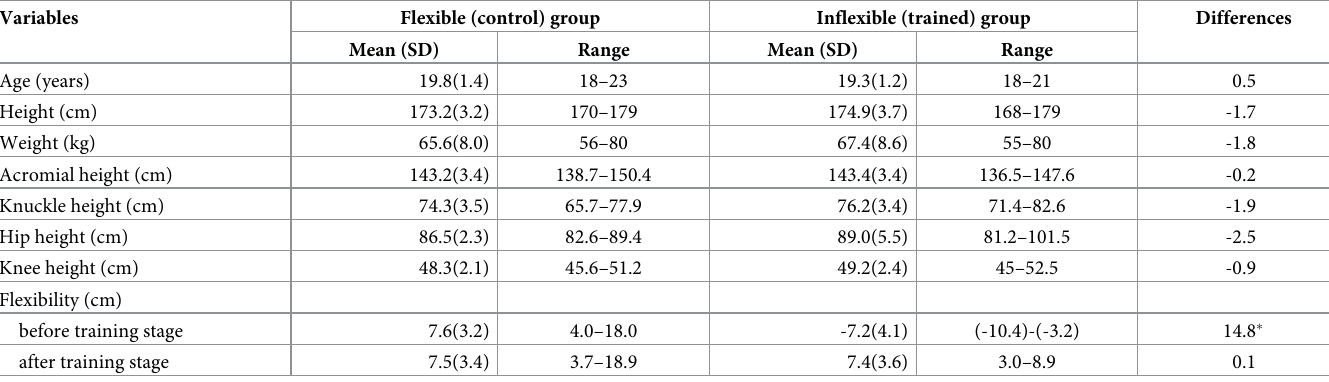
Table 1. Demographic data of the participants in the study (n = 10 for each